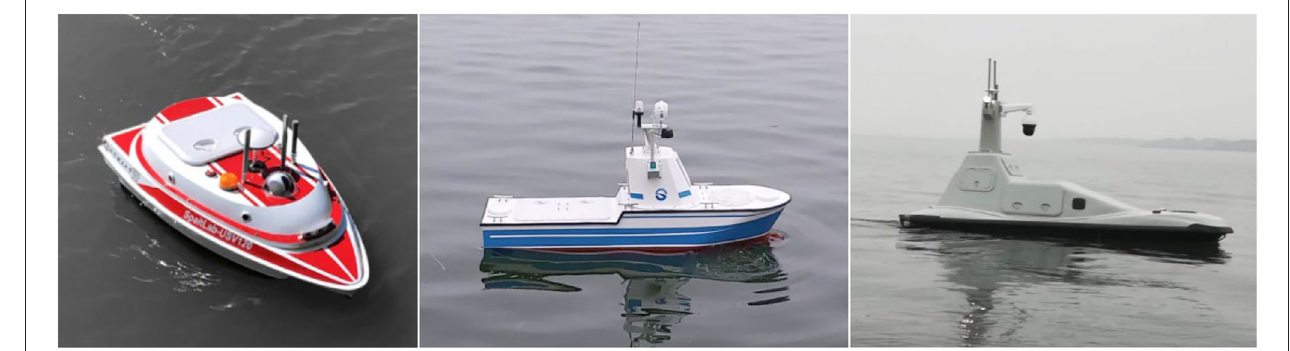
FIGURE 10 | Unmanned surface vehicles for the